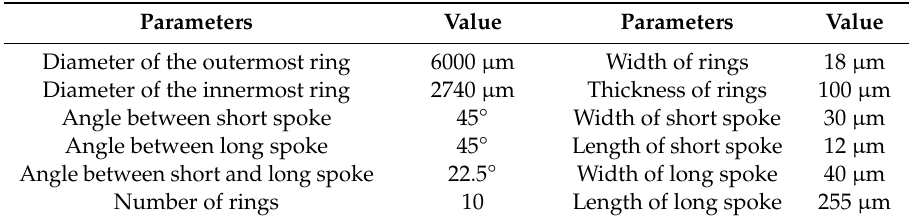
Figure 1. Geometry of the disk resonator gyroscope (DRG). Table 1. Geometrical parameters of the DRG. Table 1. Geometrical parameters of the DRG.